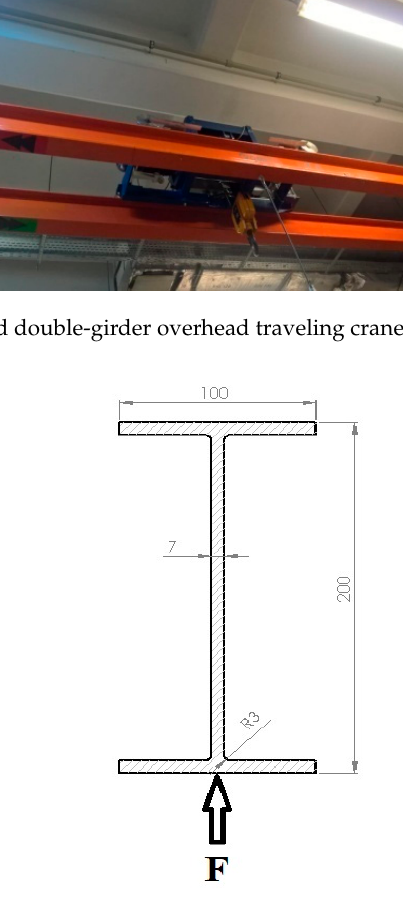
Figure 3. Crane’s girder cross-section, where: F is tested plane.